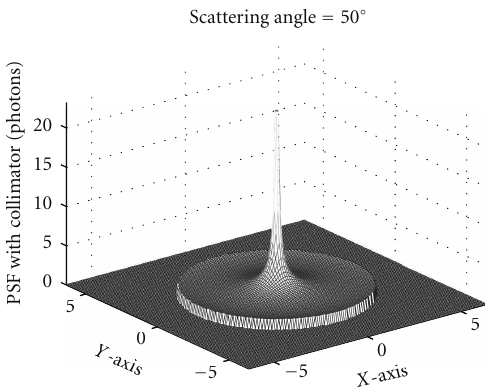
Figure 6: The PSF at a scattering angle of 50 degrees with collimator (reprinted with permission from